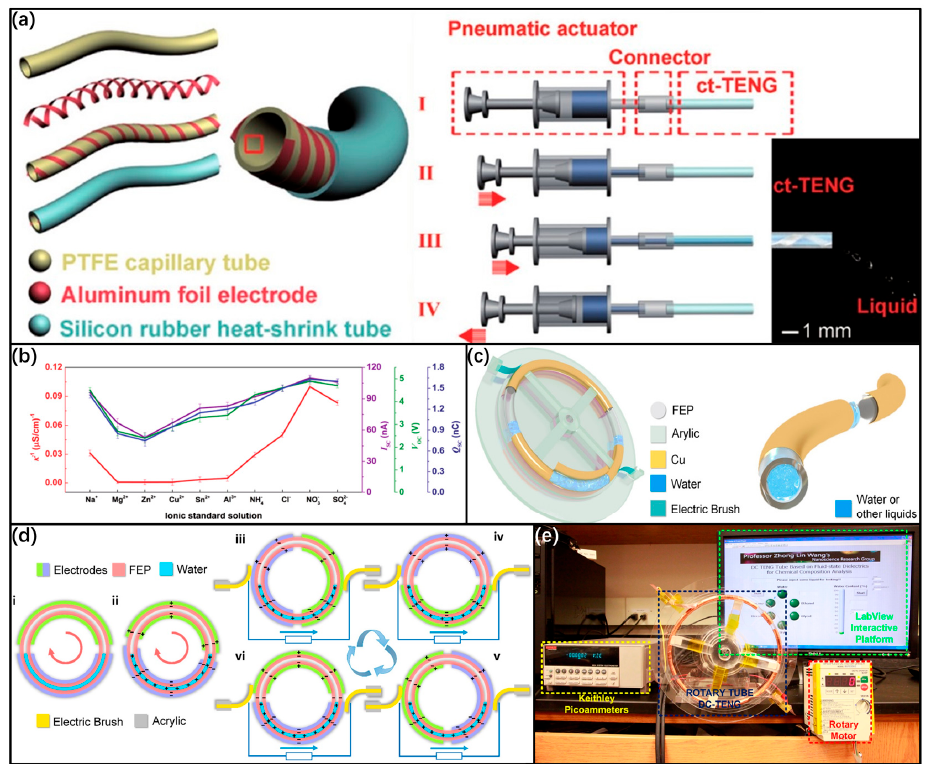
Figure 2. ( a ) The structure, working steps, ( b ) electrical output results, and conductivity curves of the system [41]. ( c ) Model and ( d ) working mechanism of the direct-current TENG [44]. ( e ) Water quality detection and chemical composition analysis platform [44].